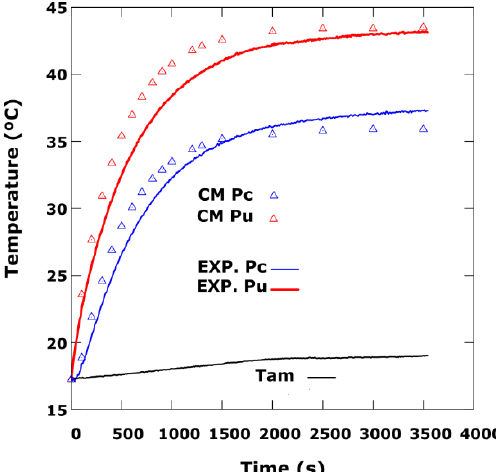
Figure 21. Radial simulations of the CM with adjustment parameters h e ff (Cu) = 8.2, h e ff (Fe) = 32 W / m 2 K, and experimental curves obtained in Pu and Pc for w r = 16.33 rad/s.